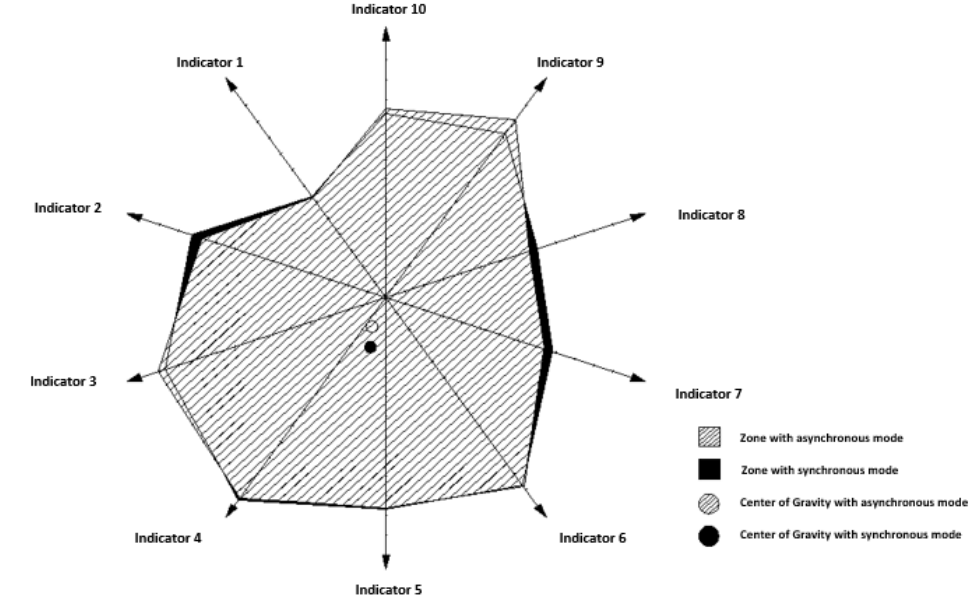
Figure 3. Graphical representation of the area of importance and the center of gravity in the supervision of the indicators of the SULODITOOL ® tool in post-compulsory education (scenario 5 and 6). Source: own elaboration through the AutoCAD ® application.